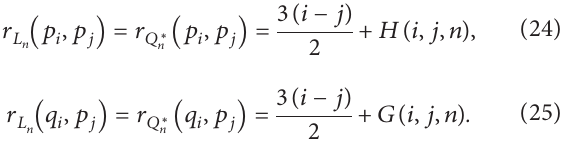
n by a circuit reduction about points